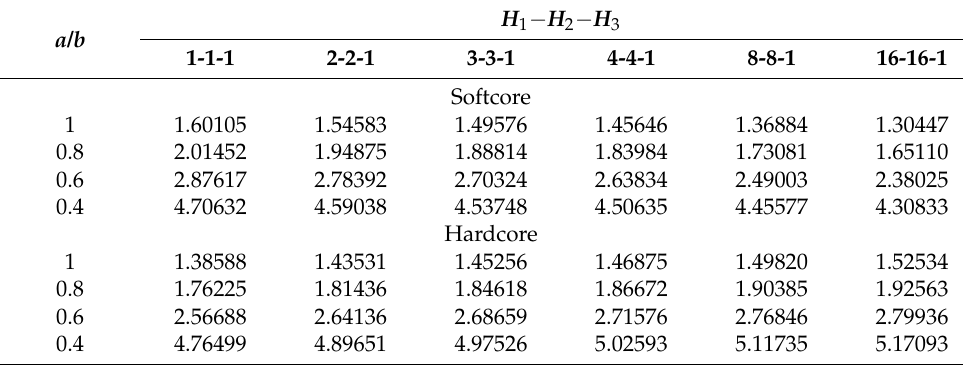
Table 7. The effect of aspect ratio on the calibrated fundamental frequencies, ω , for simply supported FG sandwich plates with homogeneous cores ( n = 1, b / h = 10 ).